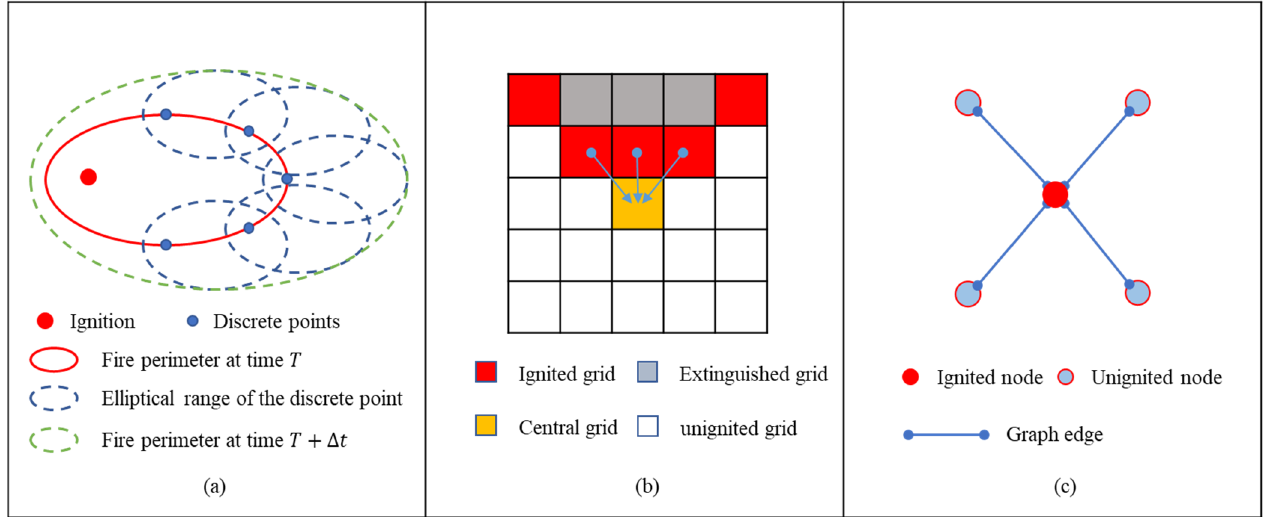
Figure A1. Spread patterns. ( a ) FARSITE model; ( b ) CA model; ( c ) IGN model.